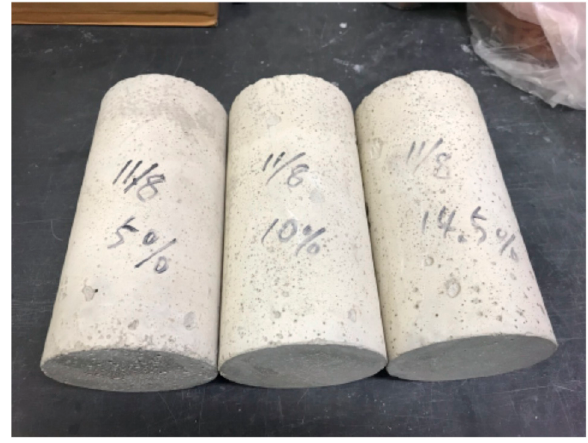
Figure 1. Test specimens.